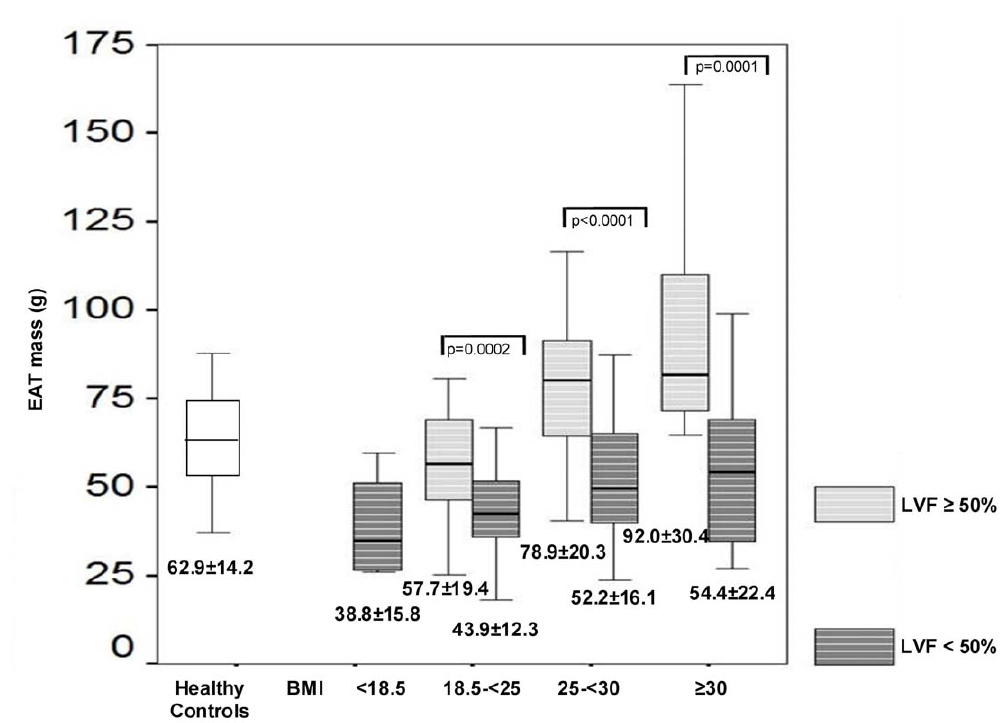
Figure 5. Comparison of EAT in different stages of obesity with regard to LVF. The box plots compare the EAT mass in healthy controls (white box plot) and CAD patients with preserved LVF (LVF $ 50%, light gray striped box plot) and patients with reduced LVF (LVF , 50%, dark gray striped box plots) in different stages of obesity as defined by BMI. The p-values for the differences between CAD patients with preserved and reduced LVF are given. The EAT mass is depicted below the box plots as mean 6 standard deviation, the line in the box plots indicates the median value of the data. In patients with CAD the EAT mass increased with augmentation of body mass index. Comparing CAD patients with the same degree of obesity, the EAT mass was dependent on LVF, revealing a significantly lower increase in EAT in CAD patients with reduced LVF compared to those with preserved LVF. Abbreviations: BMI: body mass index, CAD: coronary artery disease, EAT: epicardial adipose tissue, LVF: left ventricular function.